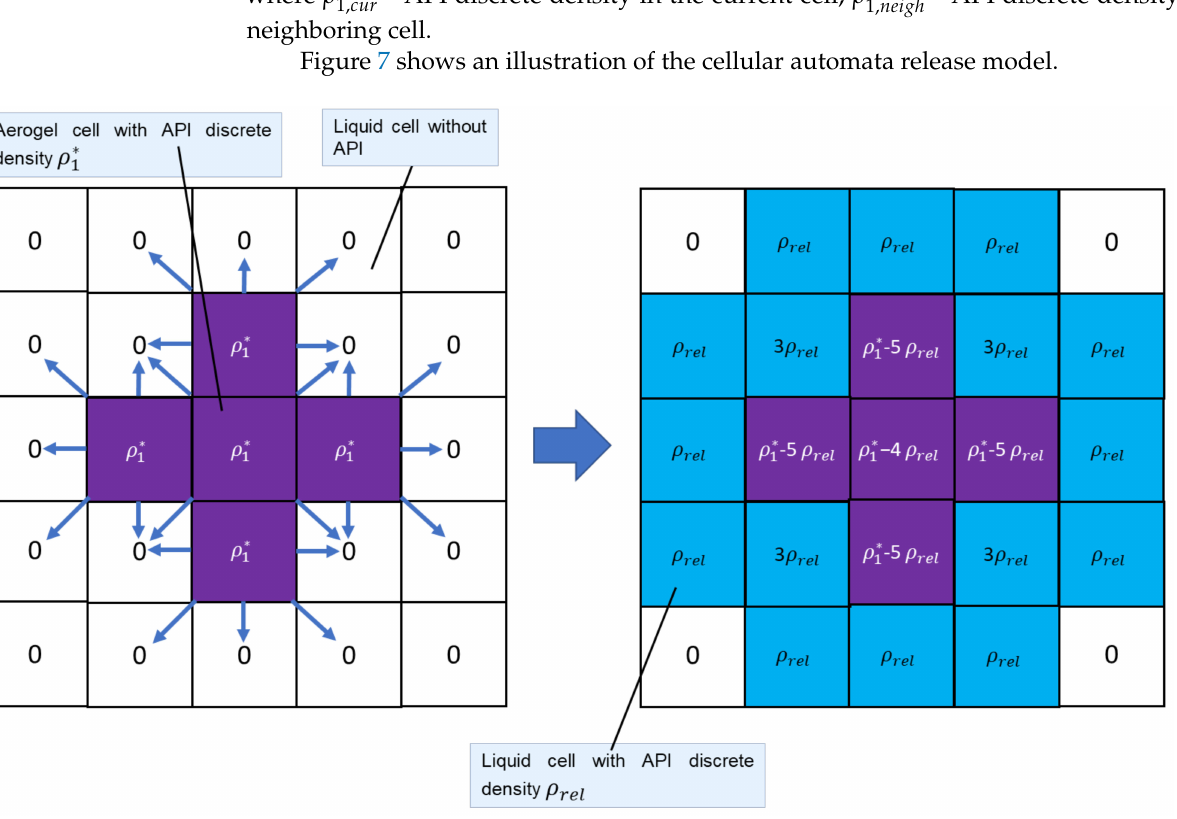
Figure 7. API release from “Aerogel with impregnated API” cells in neighboring “Liquid”